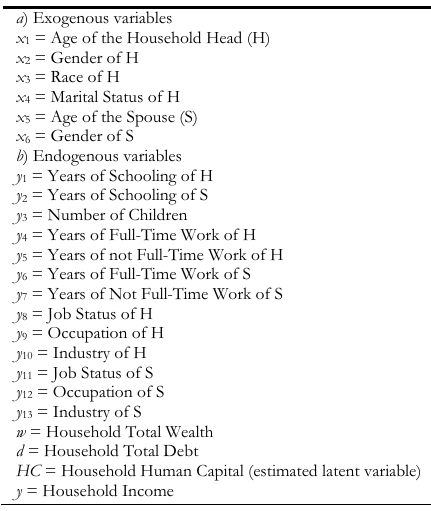
Exogenous and endogenous variables in the recursive Dagum